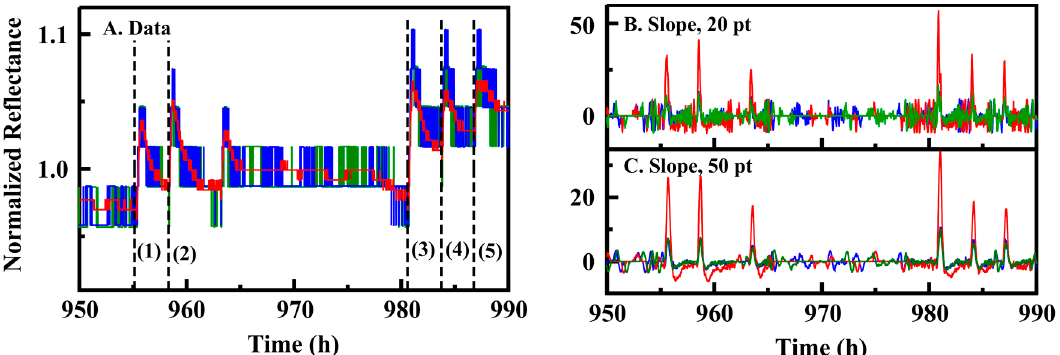
Figure 4. ( A ) PT5 data (PT5; 30 s sampling interval; 100 ms integration) is presented including